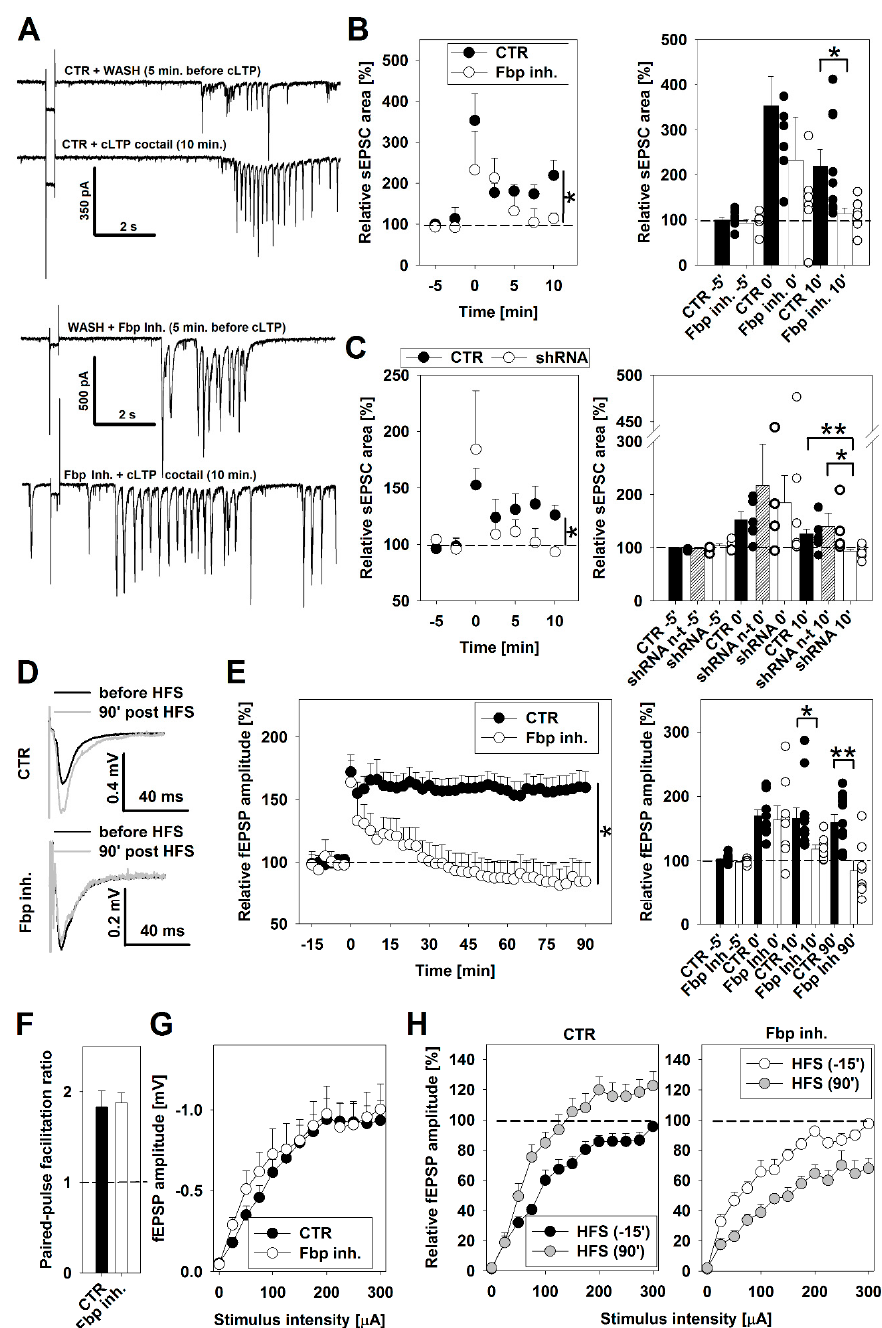
Figure 4. Impact of Fbp2 on synaptic potentiation of excitatory synapses. ( A ) Exemplary traces of spontaneous excitatory postsynaptic currents (sEPSCs) recorded in hippocampal neuronal cultures. sEPSCs were recorded continuously before (“WASH”) and for 10 min following pharmacological induction of LTP. The upregulation of frequency and amplitude of sEPSCs is more pronounced in control conditions (upper panel), as compared to that observed in the presence of Fbp inhibitor (lower panel). ( B ) Time course (left panel) and relative sEPSC area change before ( − 5 min) and up to 10 min post LTP induction (right panel) in control neurons (black) and neurons incubated with the Fbp inhibitor (white). In the presence of the inhibitor, potentiation of sEPSC is significantly reduced at 10 min time point (n = 9 and 7 neurons per group, respectively, N = 3 cultures, p < 0.05; unpaired Student’s T-test). ( C ) Time course (left panel) and relative sEPSC area change before ( − 5 min) and up to 10 min post LTP induction (right panel) in control neurons (black), neurons transduced with a non-target shRNA (dashed white) and neurons transduced with shRNA against Fbp2 (white). The silencing of Fbp2 abolished enhancement of sEPSC following LTP as compared to the control group